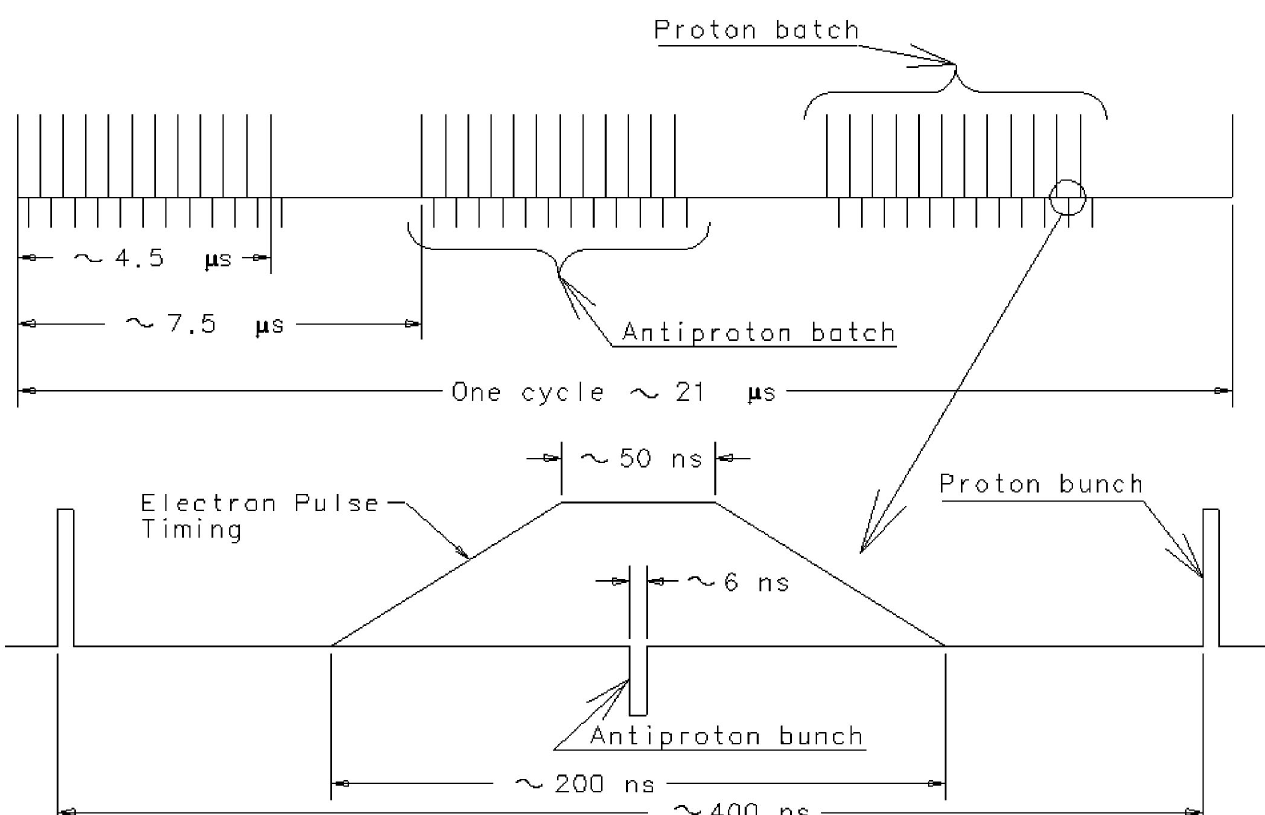
FIG. 17. The Tevatron beam structure and required TEL electron pulse